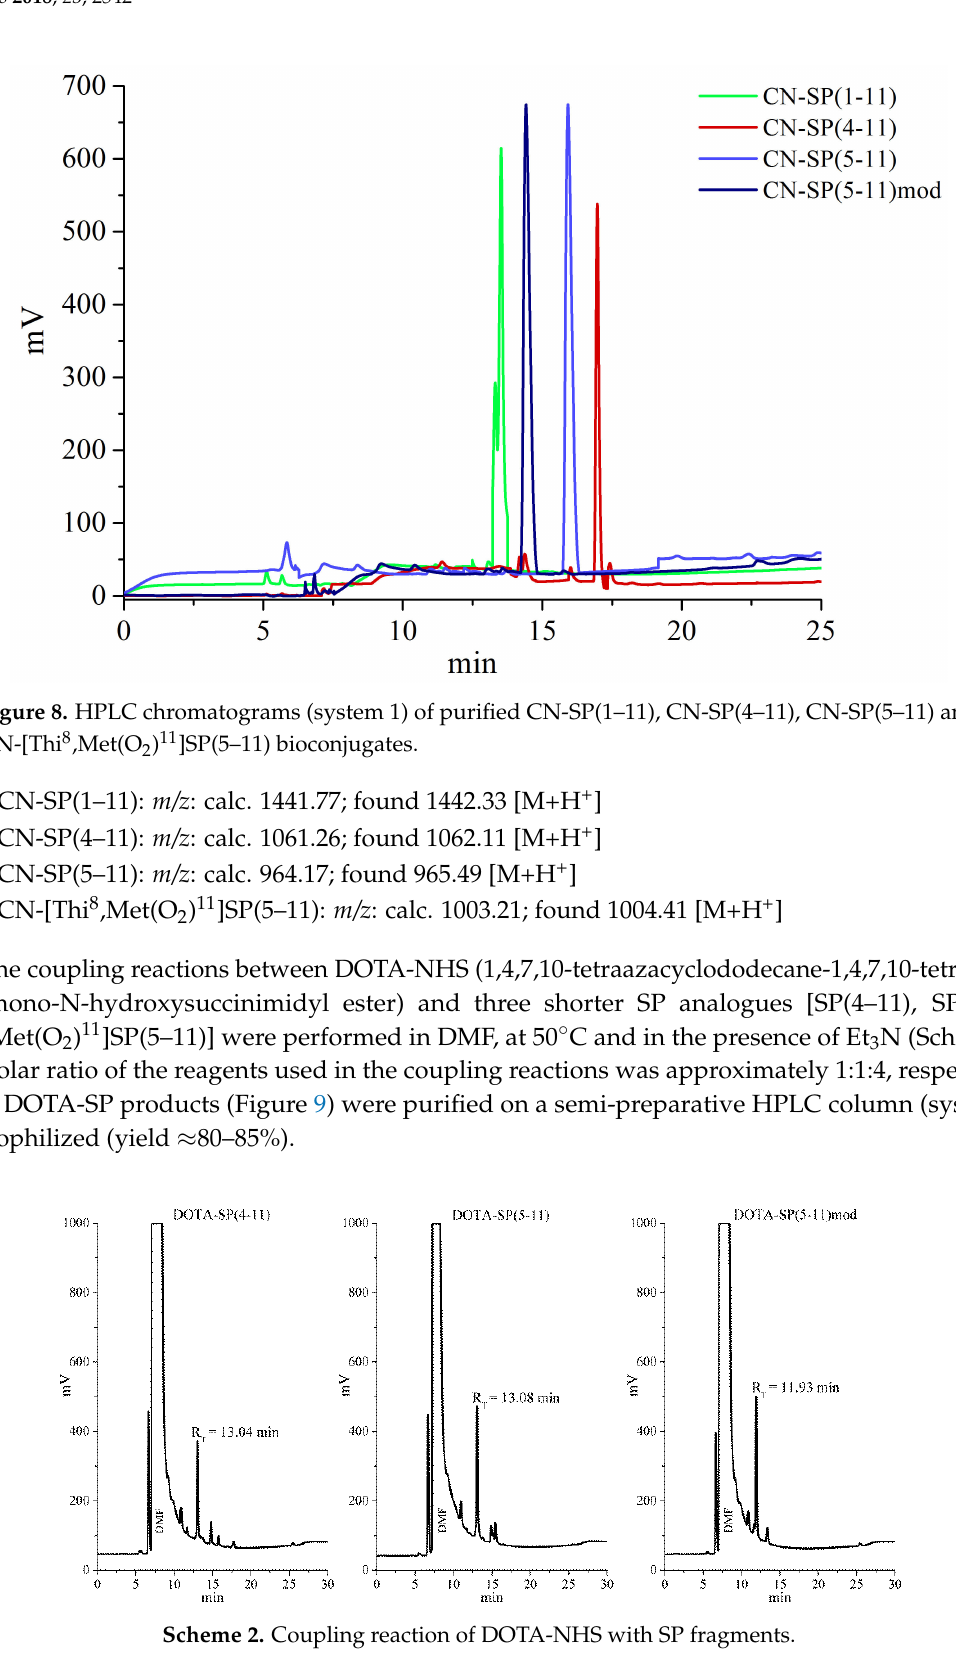
Scheme 2. Coupling reaction of DOTA-NHS with SP Figure 9. HPLC chromatograms (system 1) of reaction mixtures of DOTA-SP(4 – 11), DOTA-SP(5 – 11)